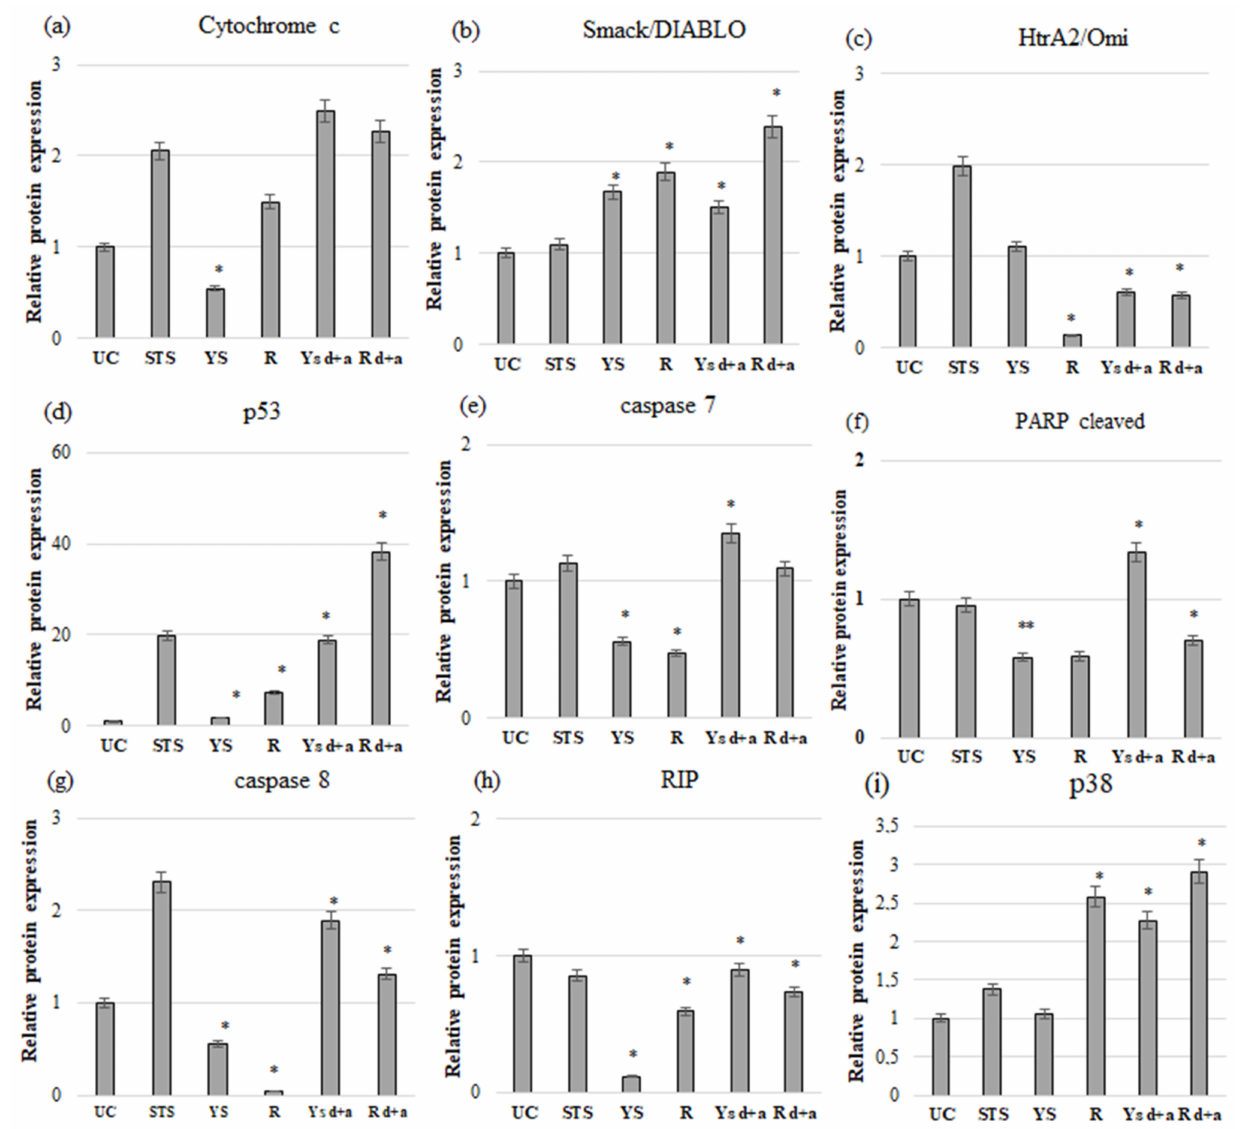
Figure 4. Expression of selected apoptosis-related proteins in MDA-MB-231 cancer cell line. UC—untreated control, STS—staurosporine, YS—native juice of young shoots of beetroot, R—native juice of beetroot, YS d+a—juice of young shoots of red beet subjected to in vitro gastrointestinal digestion and absorption, R d+a—juice of beetroot subjected to in vitro gastrointestinal digestion